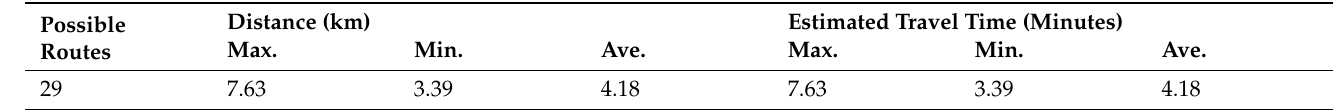
Table 4. Length of the evacuation route and the travel time by vehicle from the isolated area of Gwangwon-ri to the nearest shelter.